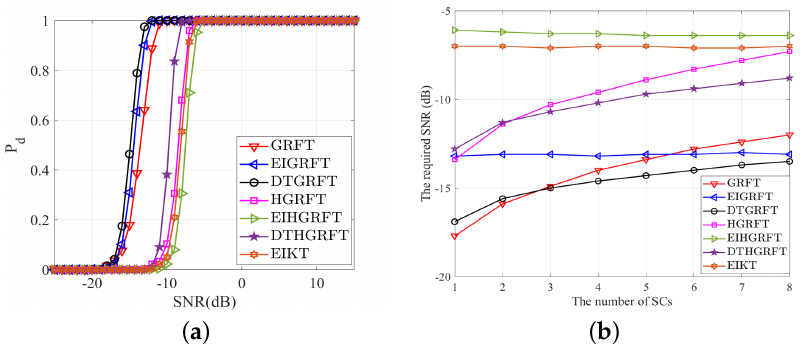
Figure 14. The comparison results of detection performances of different methods for target 1. ( a ) The curve of P d at L = 8. ( b ) The curve of demanded SNR.